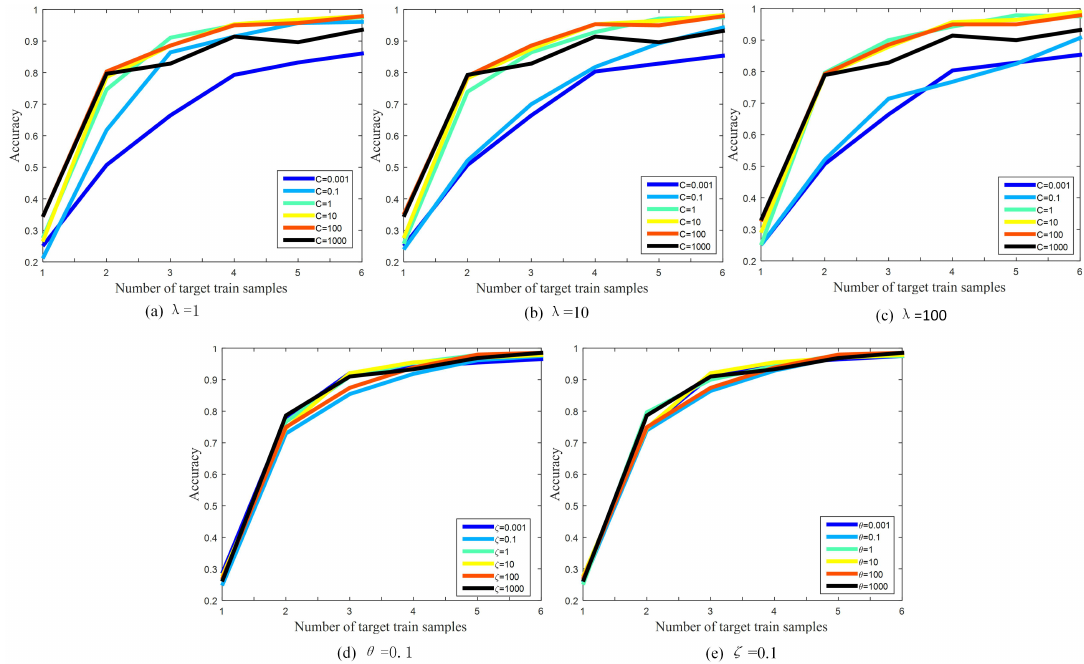
Figure 9. The performance (classification accuracy) of Multi-Fuse based SMRMKL for S1 → T1 transfer task with different trade-off parameters.